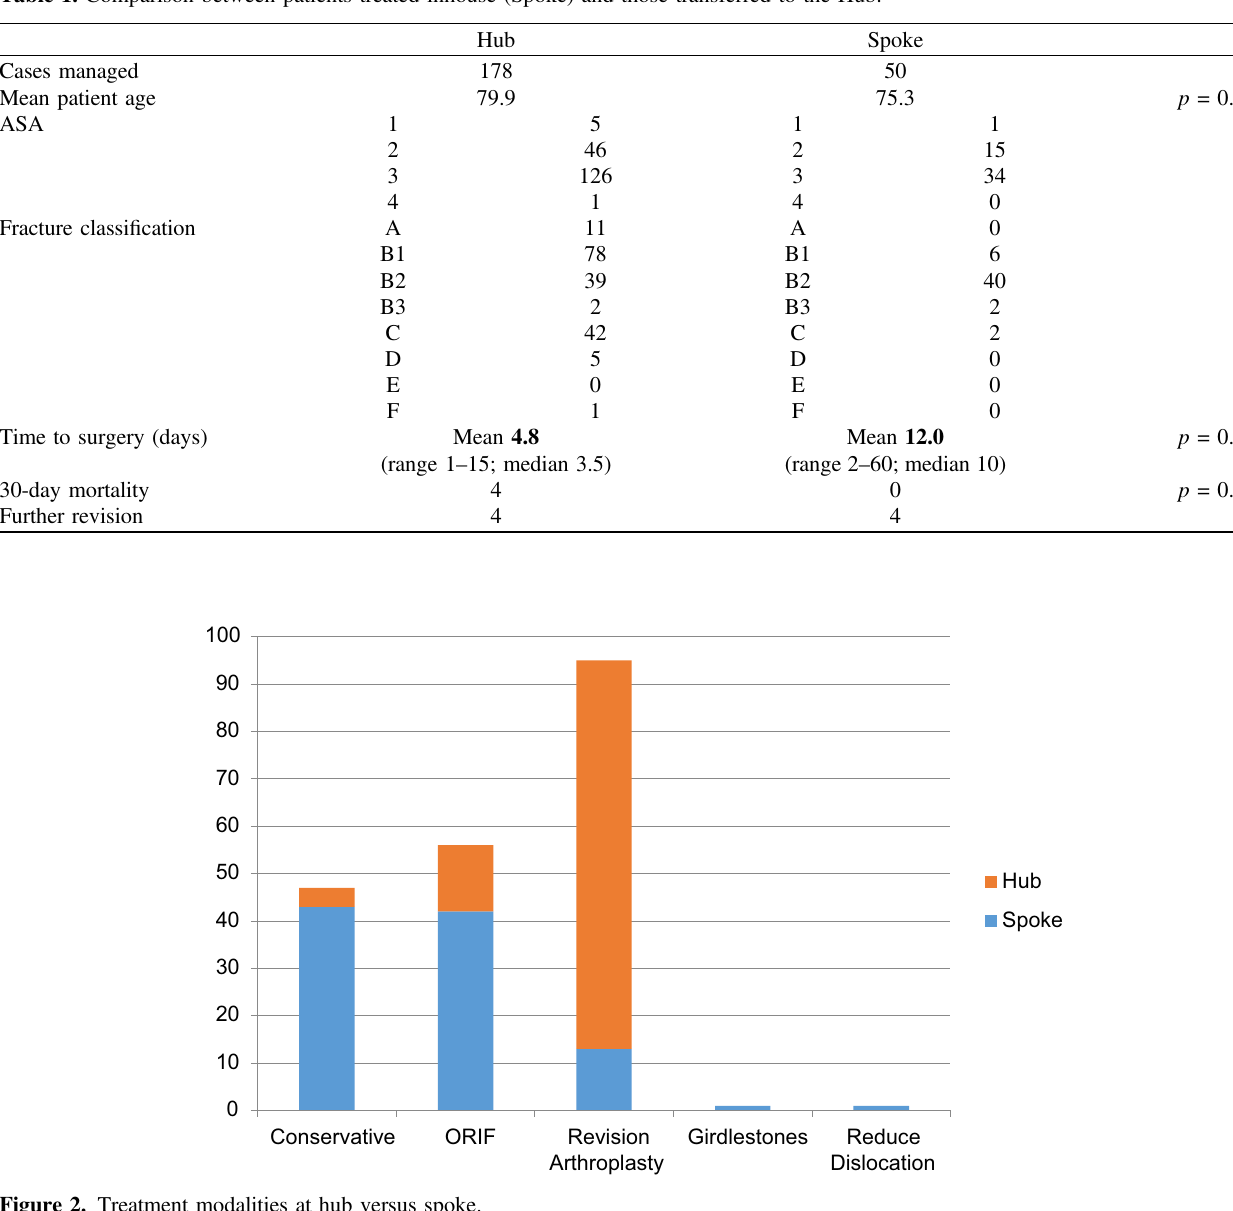
Figure 2. Treatment modalities at hub versus spoke.